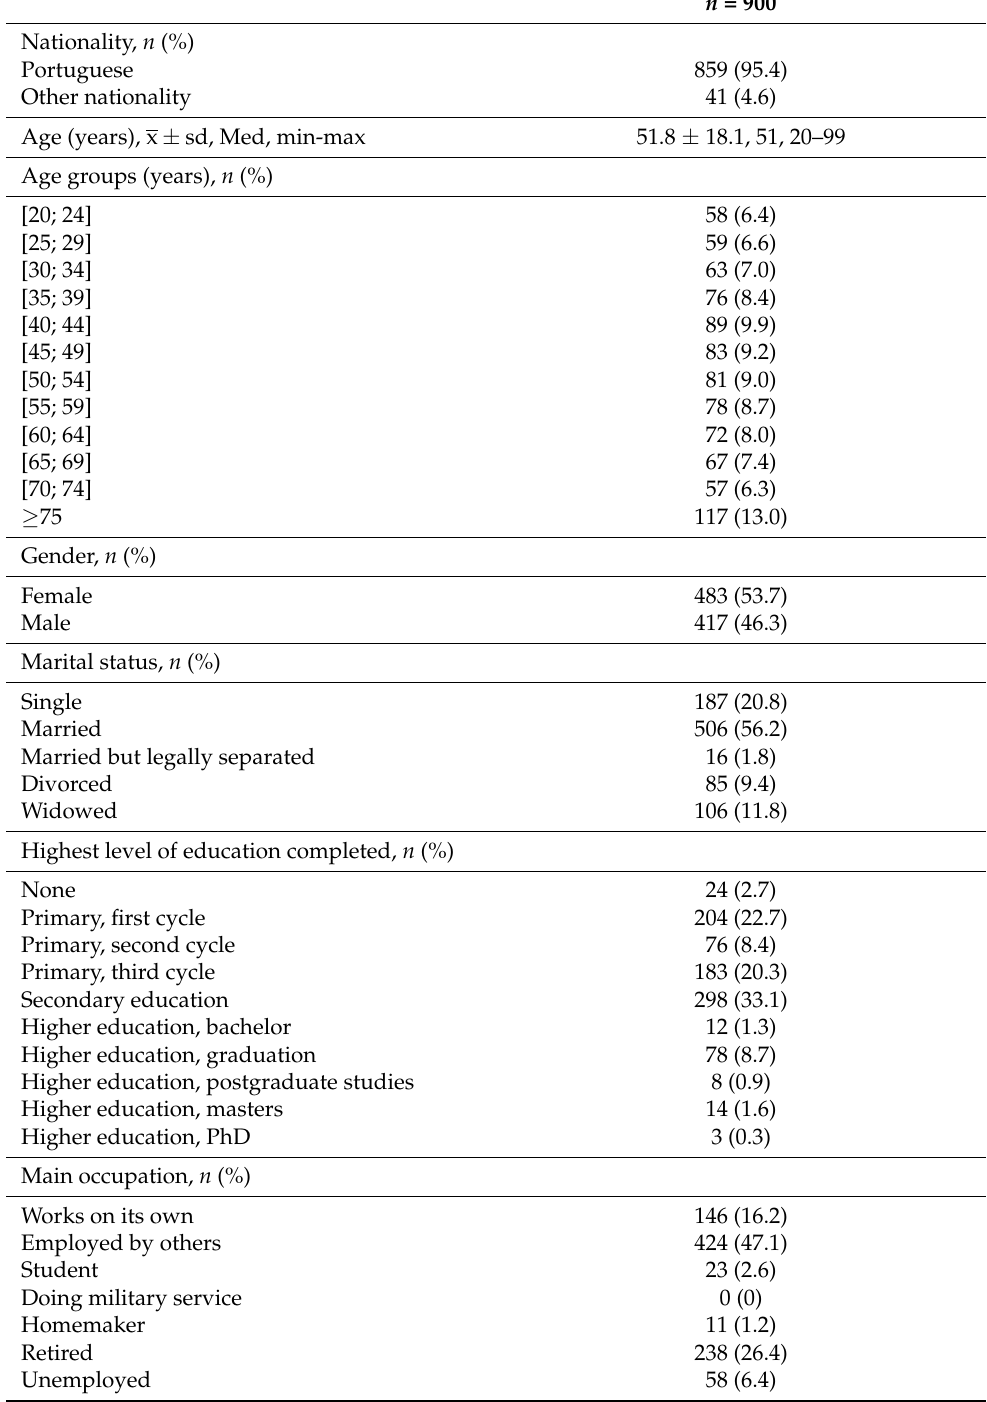
Table 1. Characterization of the sample ( n =